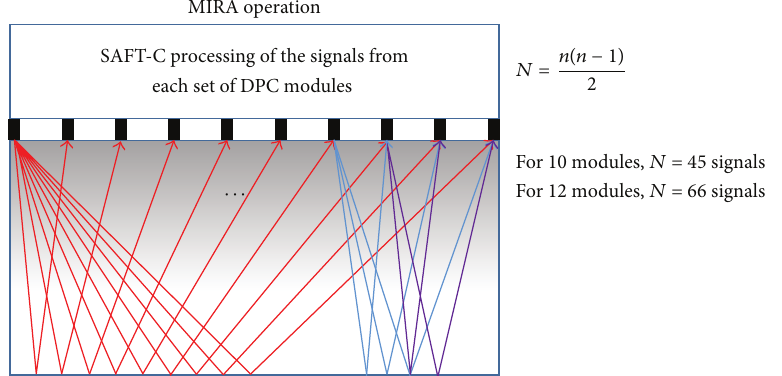
Figure 3: Schematic representation of the digitally focused array signal capturing scheme [13].